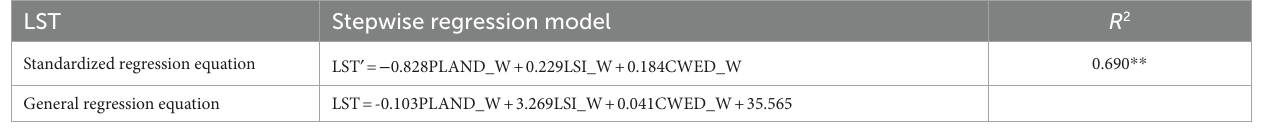
TABLE 6 Principal component regression model between LST and all selected indexes with the grid of 300 × 300 m ( n = 7,604). LST Stepwise regression model Standardized regression